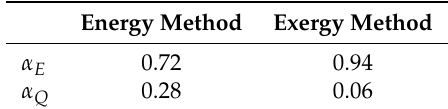
Table 7. Allocation Factor for the two different